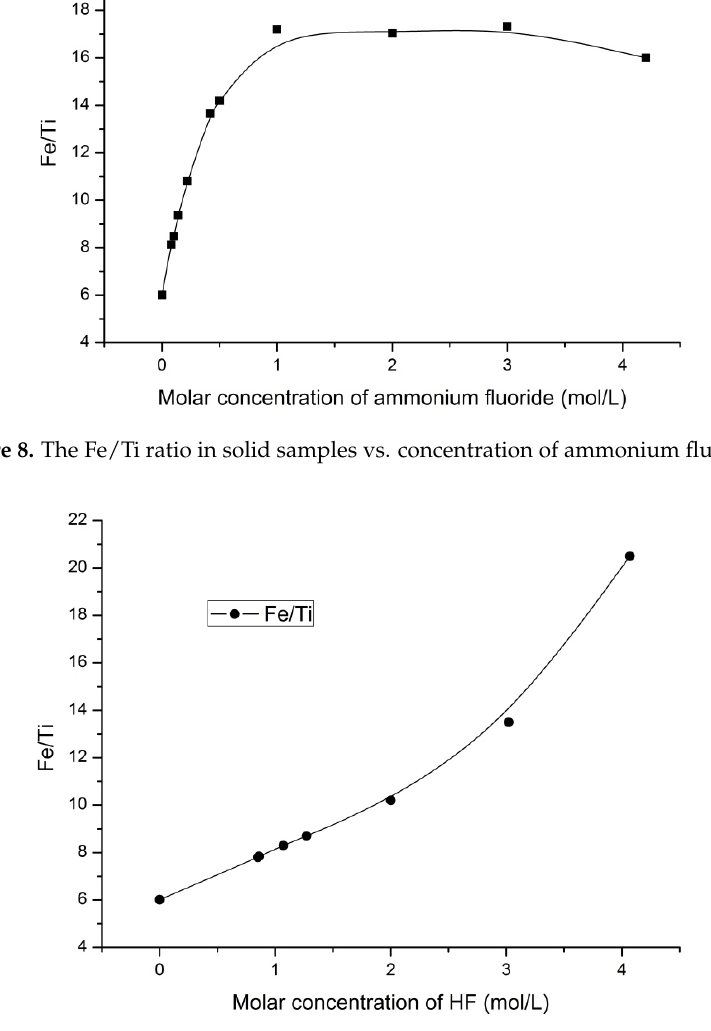
Figure 9. The Fe/Ti ratio in solid samples vs. HF concentration for a fixed ammonium fluoride concentration of 0.42 mol/L. Table 6. Impact of ammonium fluoride and hydrofluoric acid concentrations on the composition of the ferrous concentrate obtained by leaching titanomagnetite ore from the Chineisk deposit. Leaching